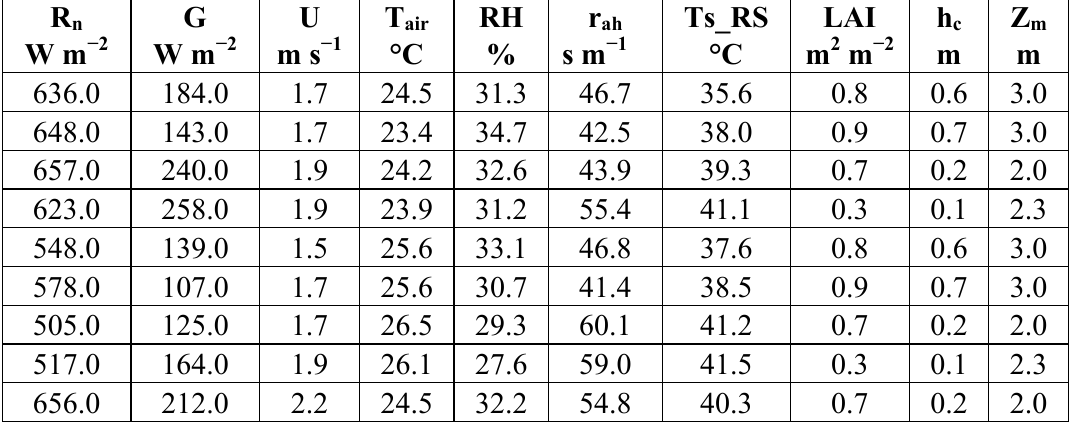
Table A1. Available Data used to perform the ANN application to model soil heat flux. R